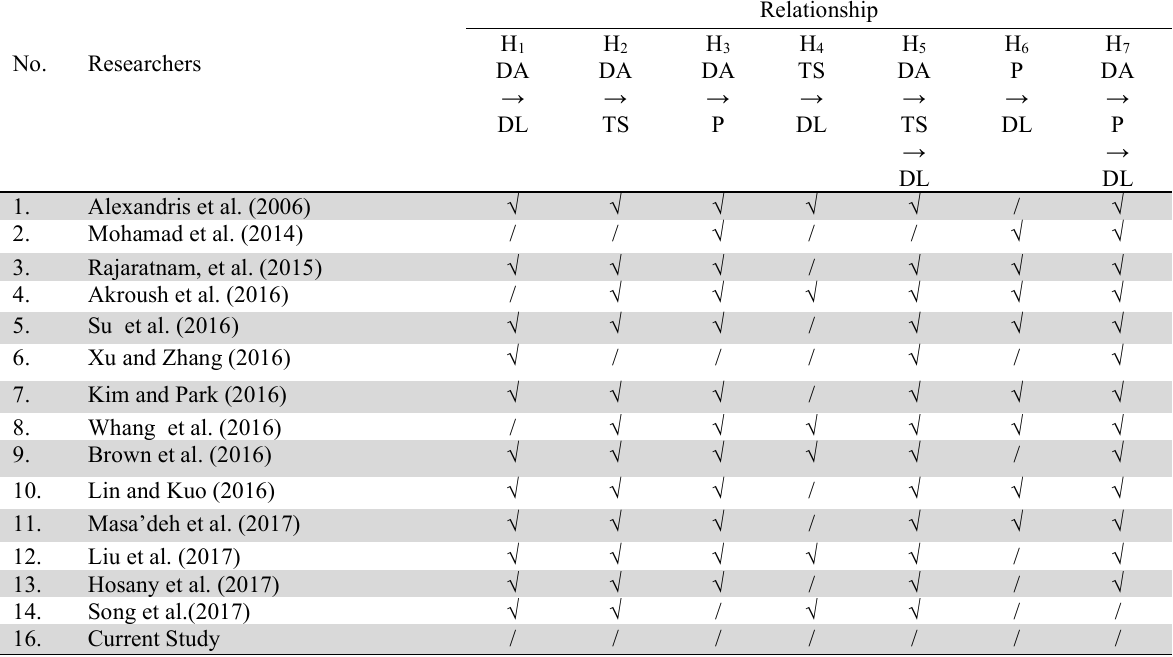
Summary of Studies on Destination Attractiveness (DA), Place Attachment (P), Tourist Satisfaction (TS) and Destination Loyalty